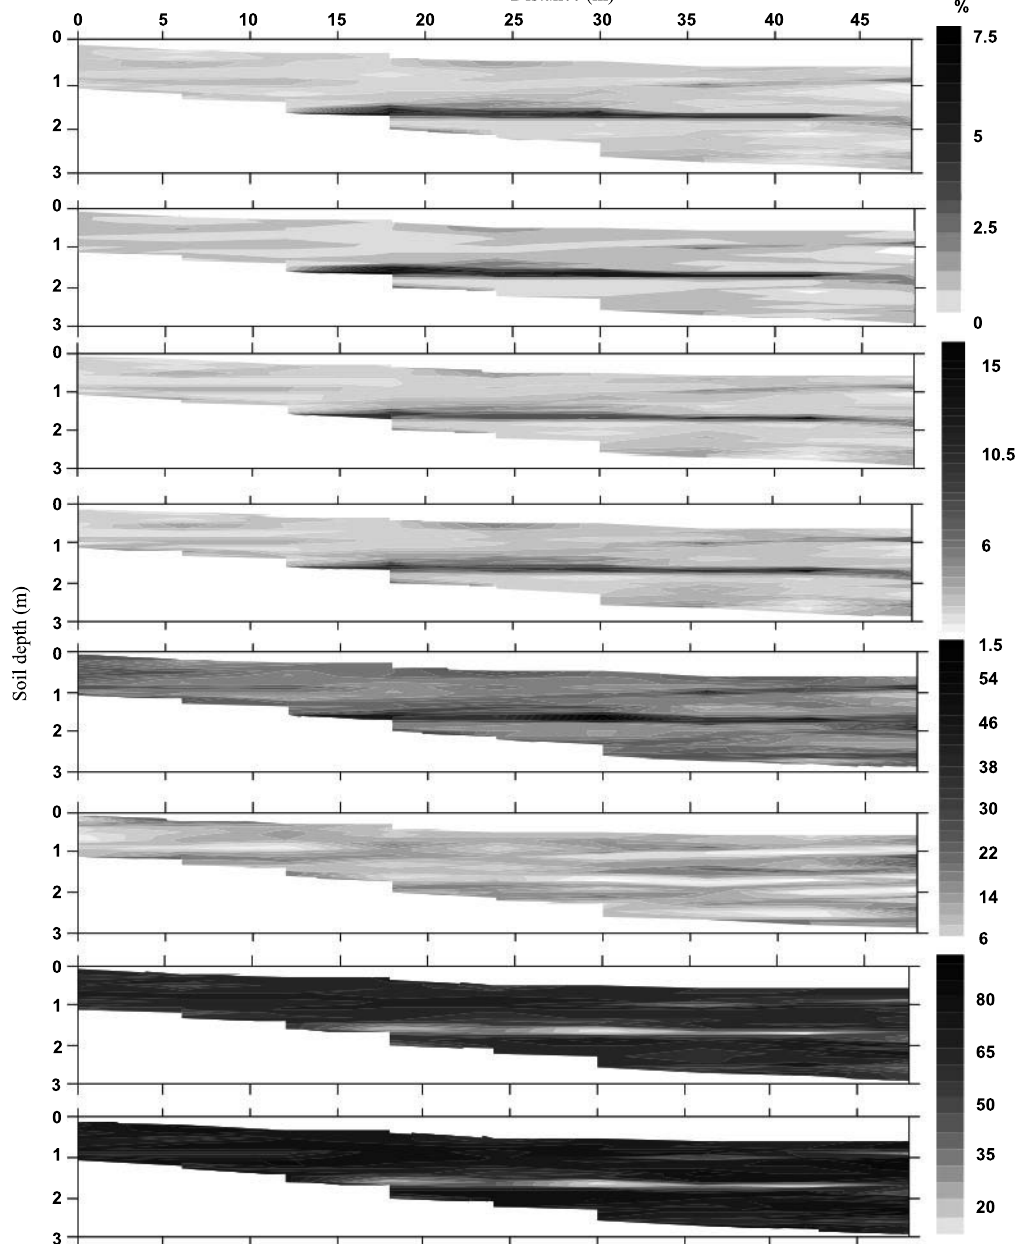
Figure 3. The redistributions of various particle sizes within Chinese taxonomy on the profile of silting deposited farmland soil (the direction of erosion flow is from 0 to